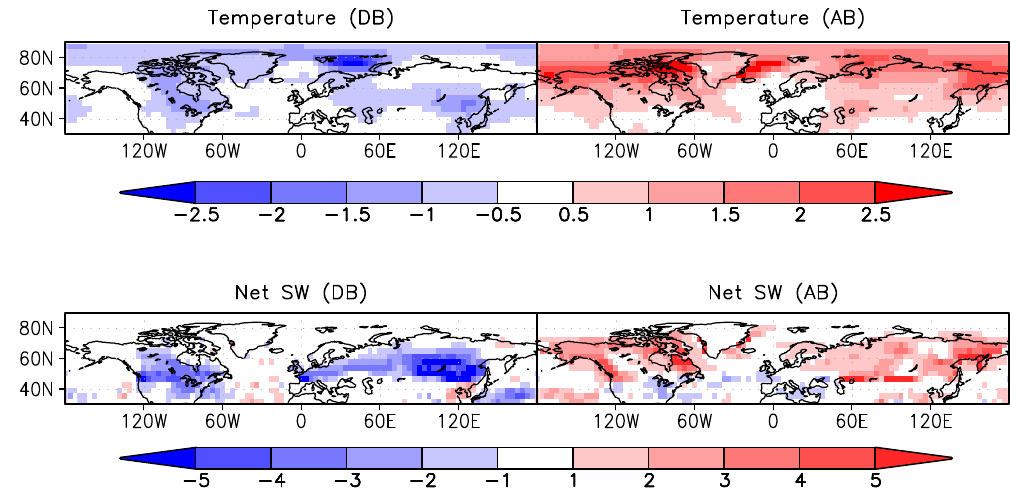
Fig. 13. Anomalies in 2m-temperature in ◦ C and net short-wave radiation in W/m 2 at the surface for boreal autumn averaged over the final 200years of the boreal deforestation (left) and boreal afforestation experiment (right).